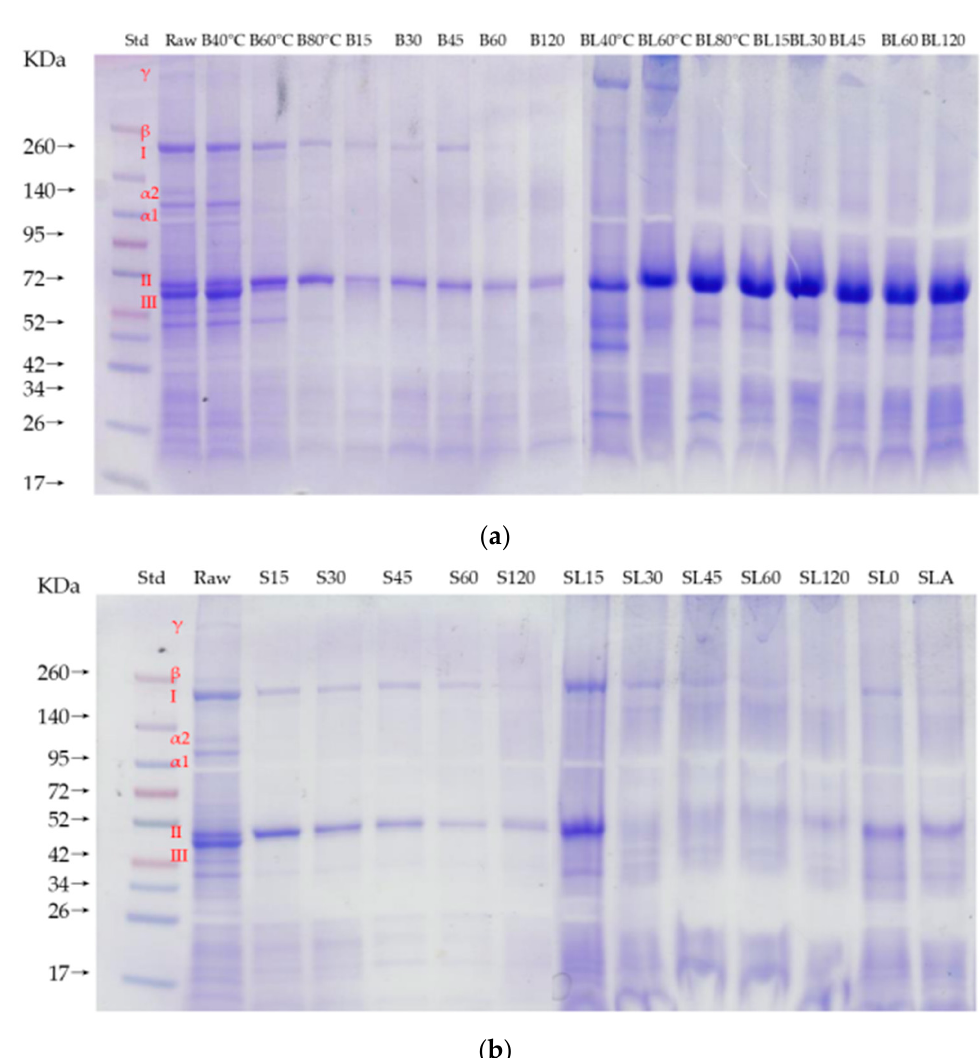
Figure 4. SDS-PAGE analysis of blanched and boiled samples ( a ) and steamed samples ( b ).